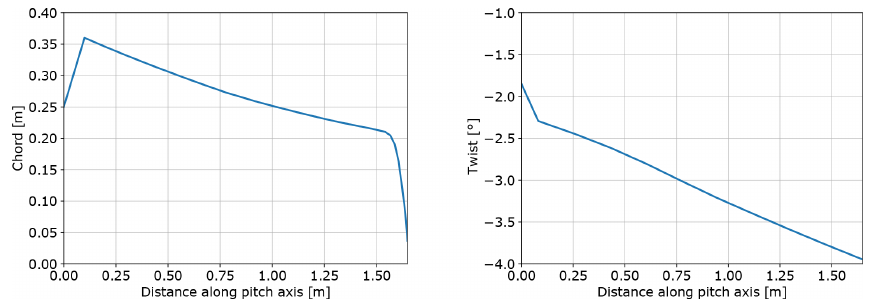
Figure 4. Planform of the tip design.